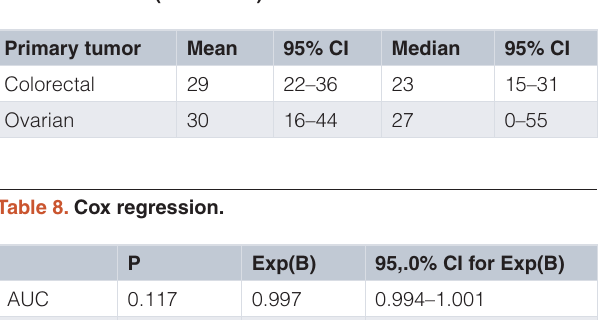
Table 7. Survival (in months).